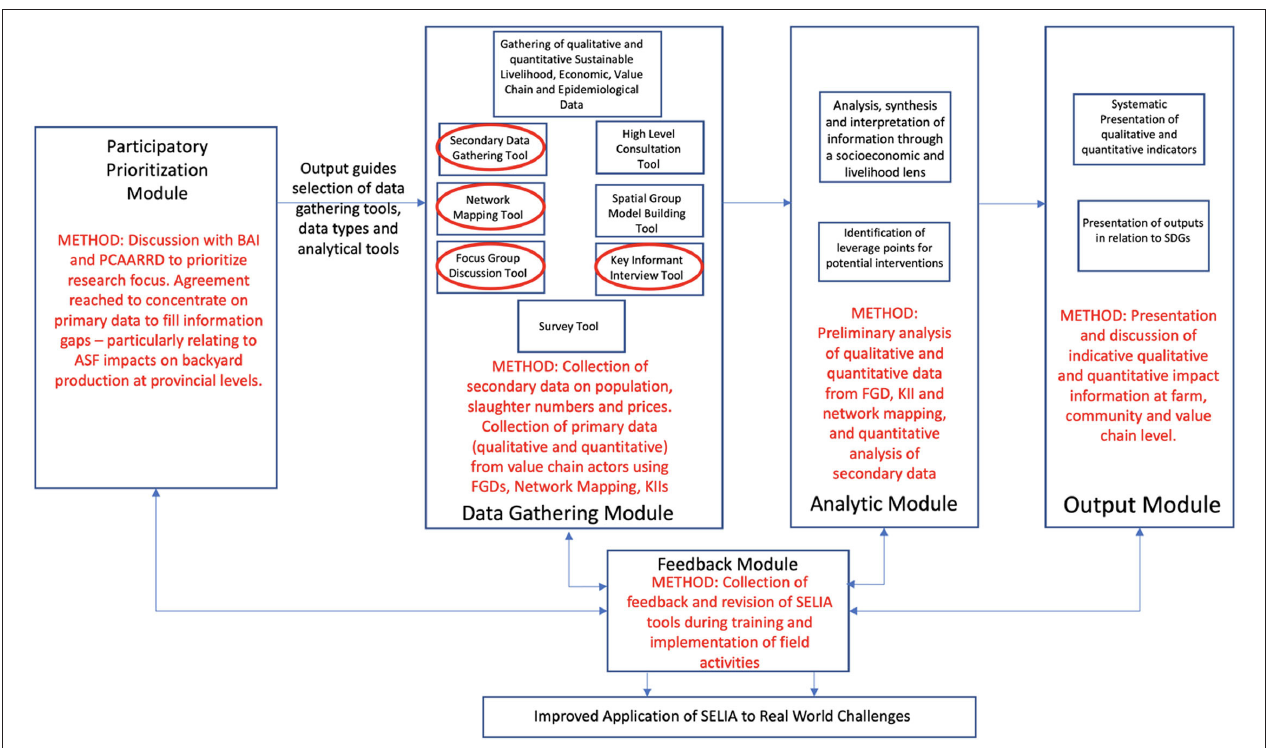
FIGURE 3 | Pilot implementation of the SELIA Framework in the Philippines (selected tools and applications in